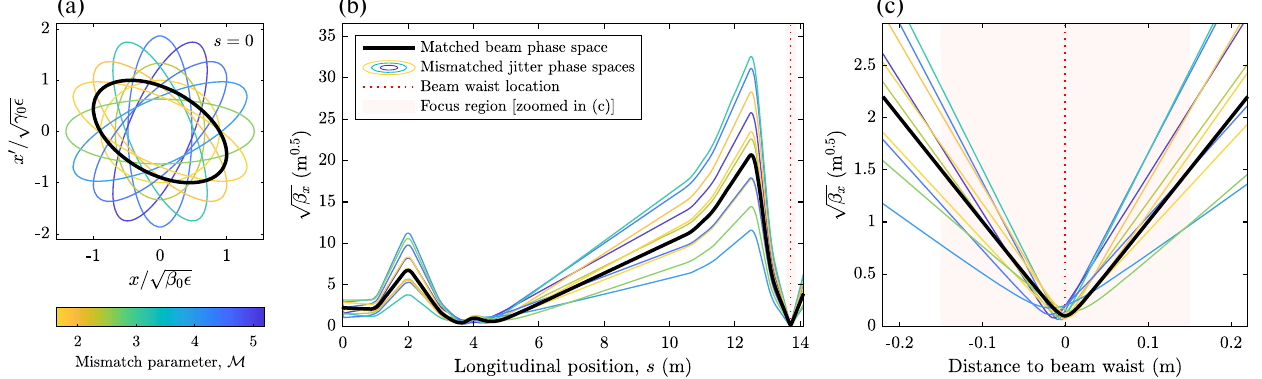
FIG. 1. Evolution of a matched beam phase space and various possible mismatched jitter phase spaces through a strong-focusing lattice. Starting out moderately mismatched (a), the jitter beta functions evolve (b) and appear to diverge from that of the matched beam beta function. Nevertheless, in the focus region (c) the mismatched jitter phase spaces are all focused to a similar waist beta function and waist location as the